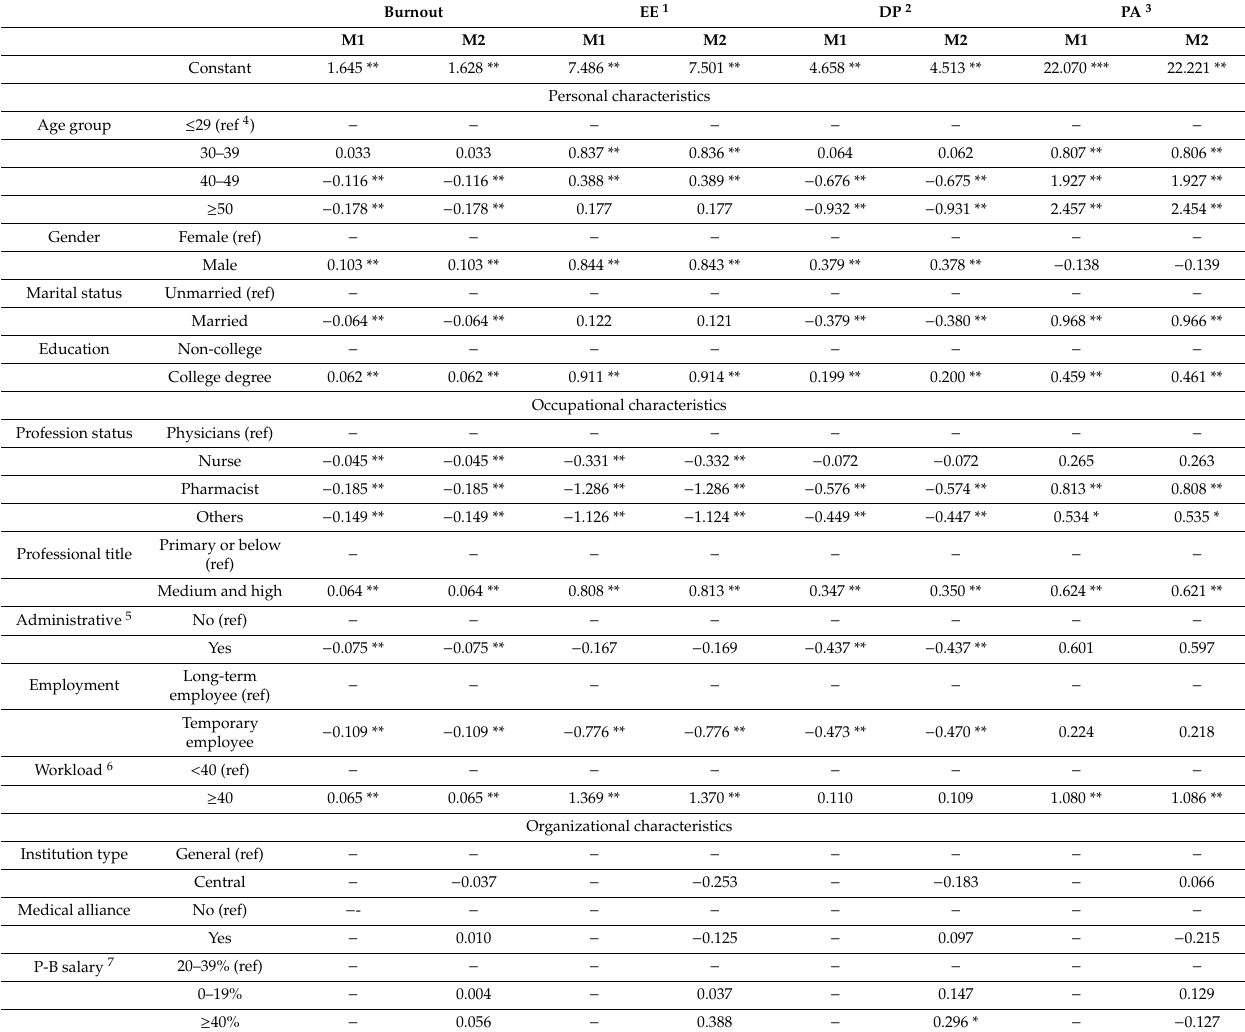
Table 6. The results of the multilevel regression analysis of the factors associated with